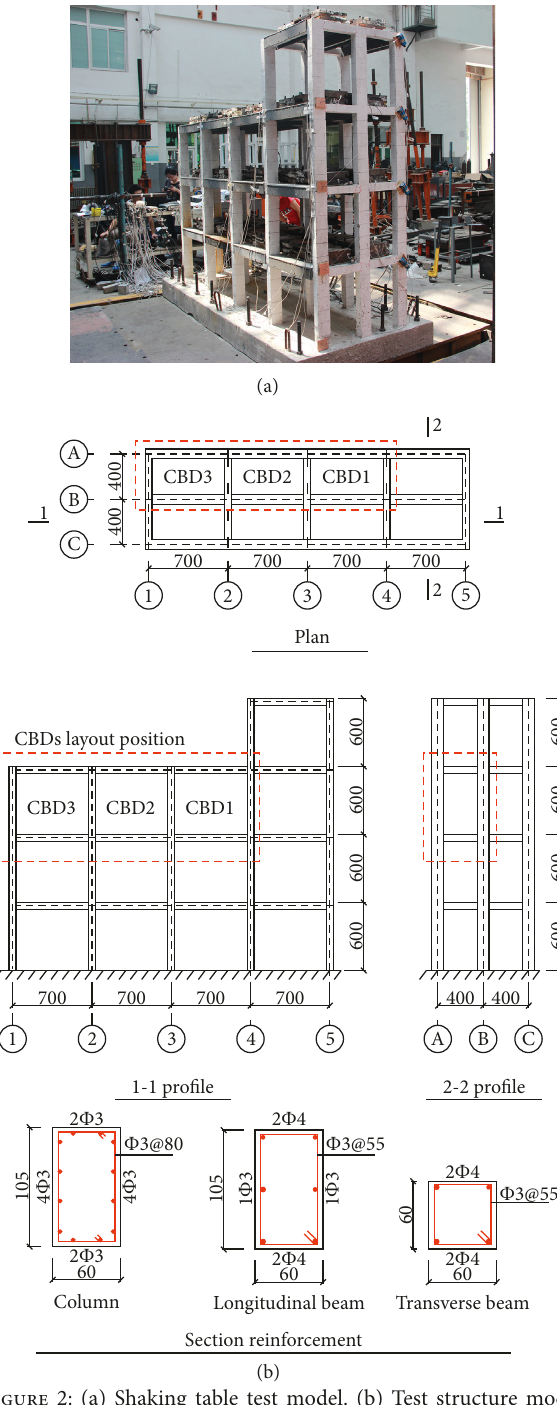
(b) Figure 2: (a) Shaking table test model. (b) Test structure model dimensions (in mm) where CBD1, CBD2, and CBD3 are the three CBDs.